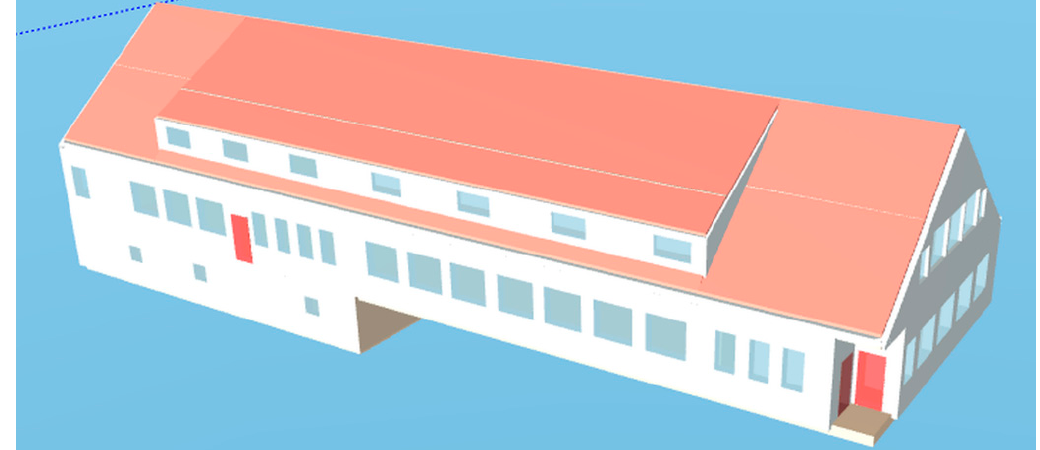
Figure 3. View of the school in the Audytor OZC program.